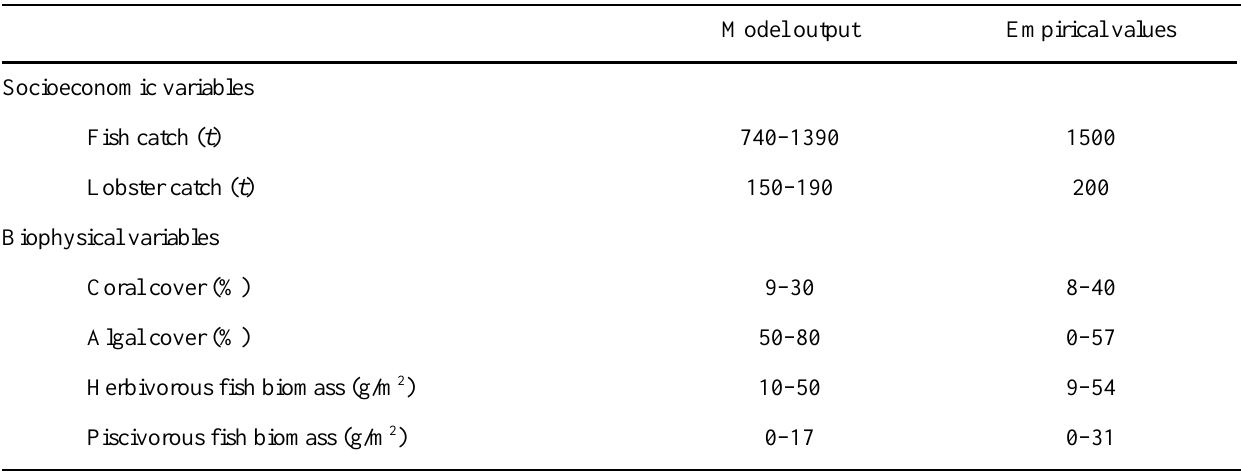
Table 1. Preliminary assessment of the behavior of the coupled model for Quintana Roo. Model output represents average end points from Monte Carlo simulations of 10 runs (each covering an 11-year simulation period from 1994–2005). Socioeconomic variables refer to the sum of fish and lobster catches for the four municipalities (Cancun, Cozumel, Riviera Maya, and Costa Maya), whereas biophysical variables are minimum–maximum ranges across municipalities. Empirical values for fish and lobster catches are estimates based on fisheries statistics for Quintana Roo in 2005 (INEGI 2005). Empirical values for biophysical variables are based on minimum–maximum ranges from ecological surveys in 2004–2005 (García-Salgado et al.